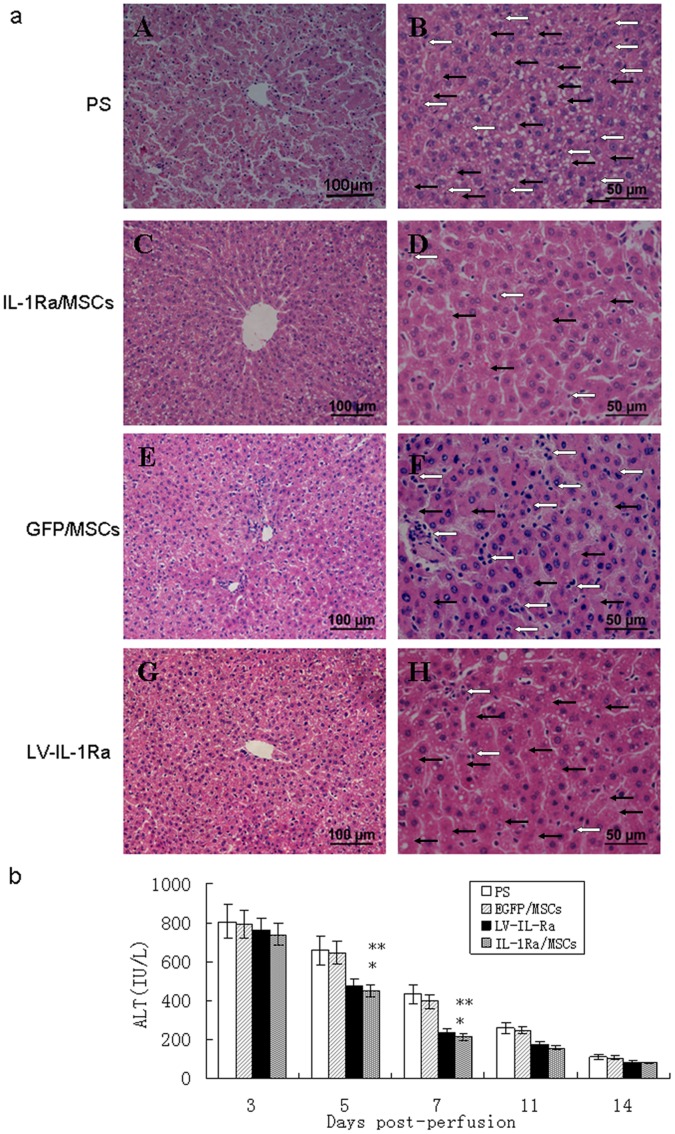
Hepatic injury in rat FHF was assessed by histological analyses and serum liver enzymes after cell perfusion: (a) Apparent structural disorder of liver lobules was detected in the physiological saline (PS) group and lentiviral-interleukin-1 receptor antagonist (LV-IL-1Ra) group (A,G).Increased infiltration of mononuclear cells(white arrow), vacuolar degeneration, and necrosis(black arrow) were observed in the PS group(B, F, H), Increased infiltration of mononuclear cells were observed in the green fluorescent protein (GFP)/MSC group(F), Increased vacuolar degeneration, and necrosis were observed in the LV-IL-1Ra group (H), as compared to the interleukin-1 receptor antagonist/mesenchymal stem cell (IL-1Ra/MSC) group (D). Original magnification ×200 (A, C, E, G), ×400 (B, D, F, H). (b) There were significantly lower alanine aminotransferase (ALT) levels in IL-1Ra/MSC rats than those in the PS and green fluorescent protein (GFP)/MSC groups by day 5 after cell transplantation. *P<0.05, when compared to the PS and GFP/MSC groups. **P>0.05 when compared to the lentiviral-interleukin-1 receptor antagonist (LV-IL-1Ra) group.